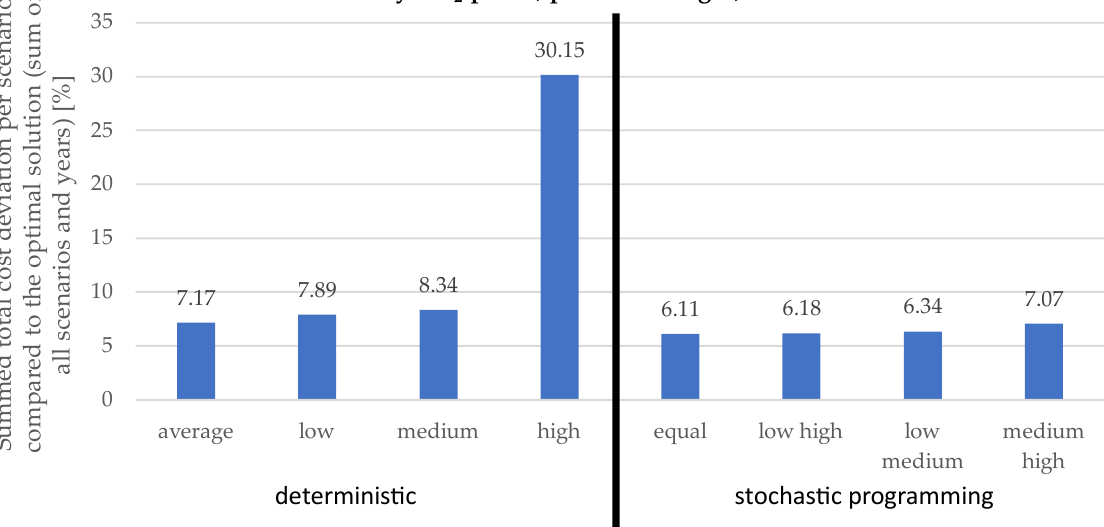
Figure 18. STCD per scenario for uncertain CO 2 prices (perfect foresight, without CCS).